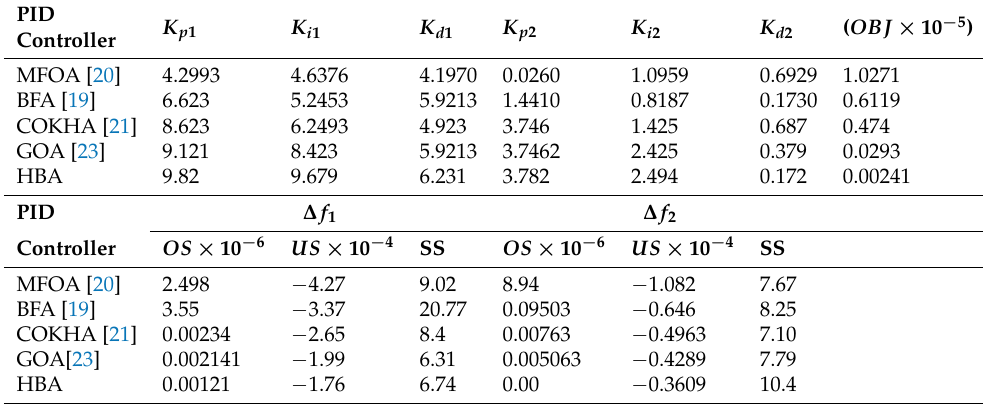
Table 2. Gain values of PID controllers for the two-area